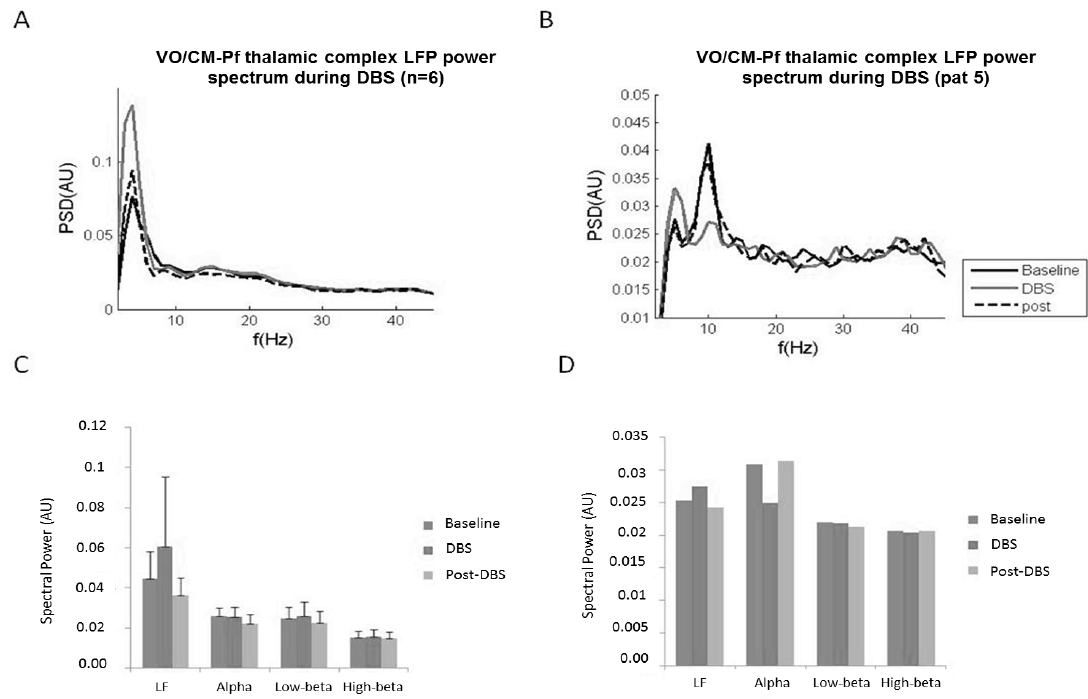
Figure 4. The LFP power spectrum obtained from the Vo/CM-Pf during ongoing DBS. ( A ) Mean power spectrum across all Vo/CM-Pf nuclei ( n = 6) for LFPs at rest (black solid line), during ongoing DBS (grey solid line), and after DBS (black dashed line). The x -axis represents frequency (Hz) and the y -axis represents the normalized power spectral density (PSD, arbitrary unit). ( B ) LFP power spectrum from a single patient (case 5 in Table 3) during ongoing DBS. The plot is organized as in panel A. ( C ) The histograms represent the mean LFP spectral power ( n = 6) for low-frequency, alpha, low beta, and high beta bands during the three experimental conditions: baseline (dark grey), DBS (middle grey), and post-DBS (light grey). Error bars represent standard errors. ( D ) The histograms represent the LFP spectral power in case 5. The histograms are organised as they are in panel